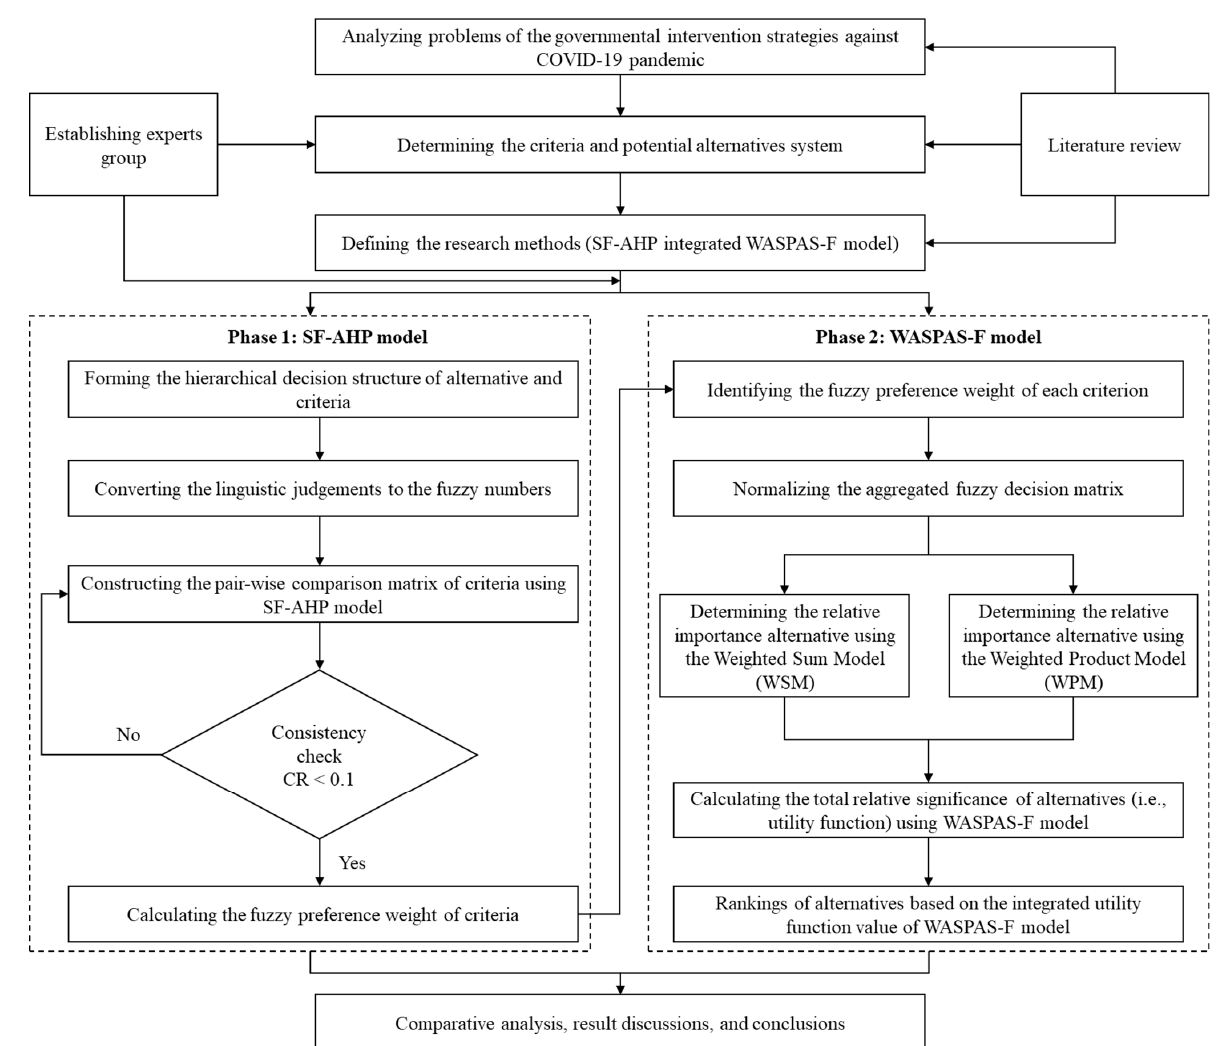
Figure 2. The research framework of SF-AHP integrated into the WASPAS-F model.